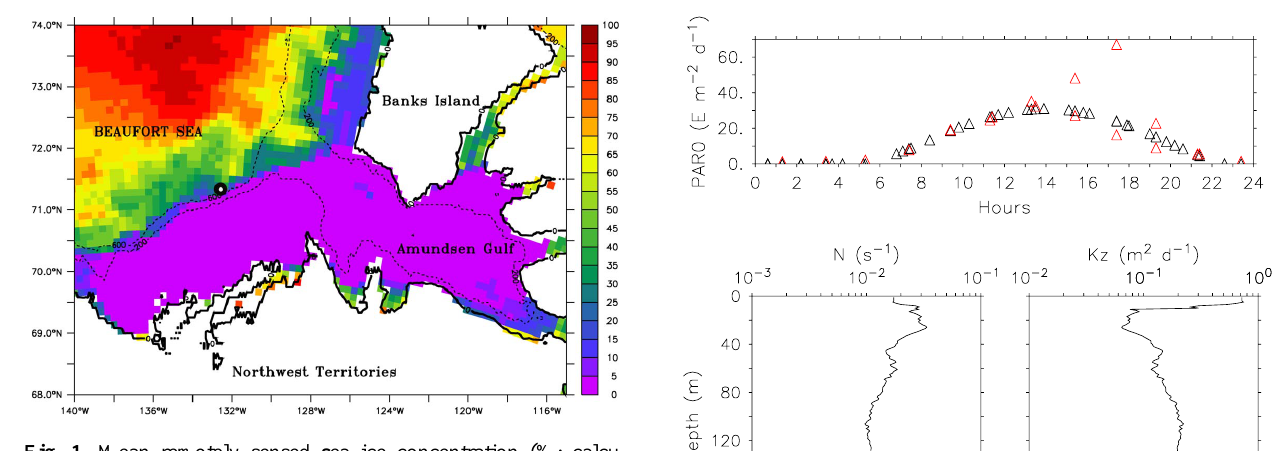
Fig. 1. Mean remotely sensed s ea ice concentration (%; calcu- lated from Special Sensor Microwave Imager (SSM/I) data from http://cersat.ifremer.fr) for the 14–16 August 2009 sampling period. Station 345 is indicated by a white point within a larger black one. The full and dashed black lines indicate the land contour and the 200m and 600m isobaths, respectively. Land appears in white. Fig. 2. Measured (14–15 August, 2009, red triangles) and fitted-